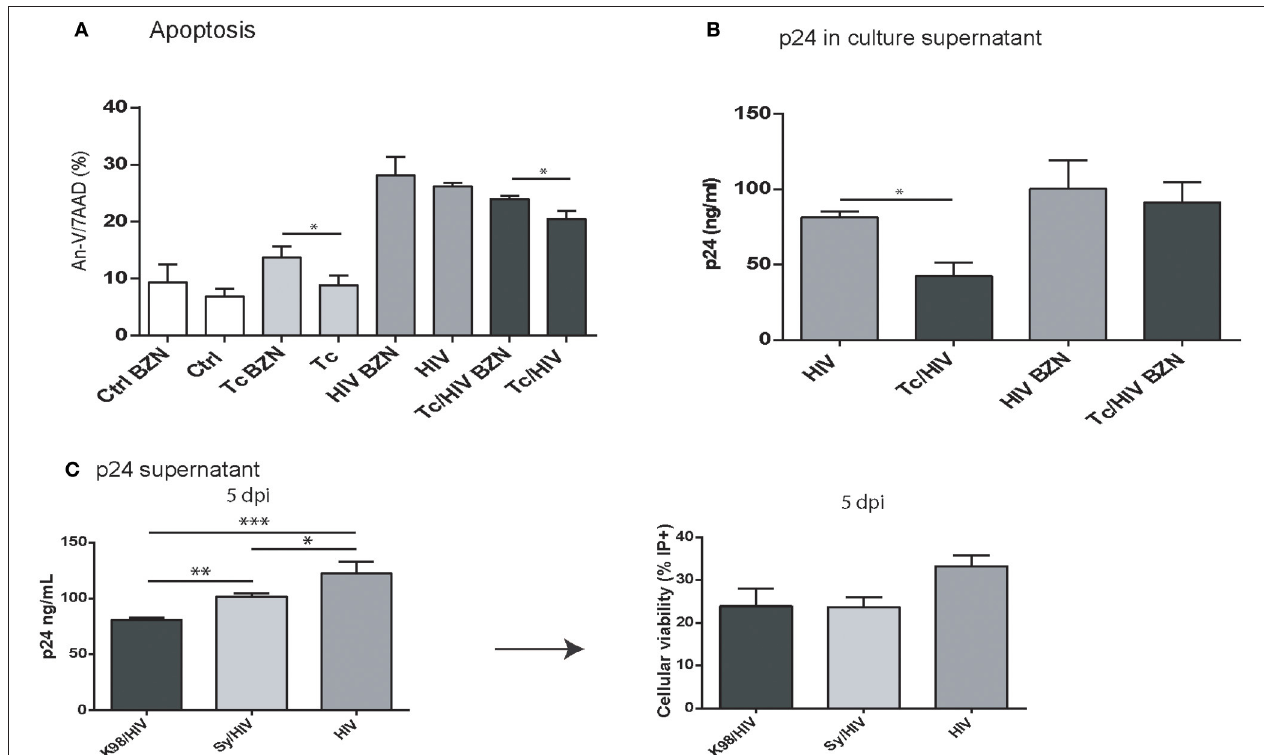
FIGURE 5 | (A,B) Benznidazole (BZN) effect on apoptosis and viral replication in astrocytes exposed to T. cruzi and HIV. (A) Flow cytometric apoptosis assay (Annexin V/7AAD) on astrocytes upon exposure to Tc, HIV, or combination (Tc/HIV) treated (or not) with BZN. Percentage of apoptotic cells at 3 dpi is shown. (B) Comparative HIV replication measured as p24 level concentration in culture supernatant (by ELISA) in monoinfected, and T. cruzi -coinfected astrocytes treated (or not) with BZN. (C) Comparative analysis of different Tc parasites (K98, Sy) impact on HIV replication and cell viability (measured by ELISA as p24 culture supernatant, and propidium iodide positive cell -PI + - levels, respectively). Mean values ± SD from three different experiments. Significant differences were assessed by an unpaired t -test and are indicated by (* P < 0.05, ** P < 0.01, and *** P <